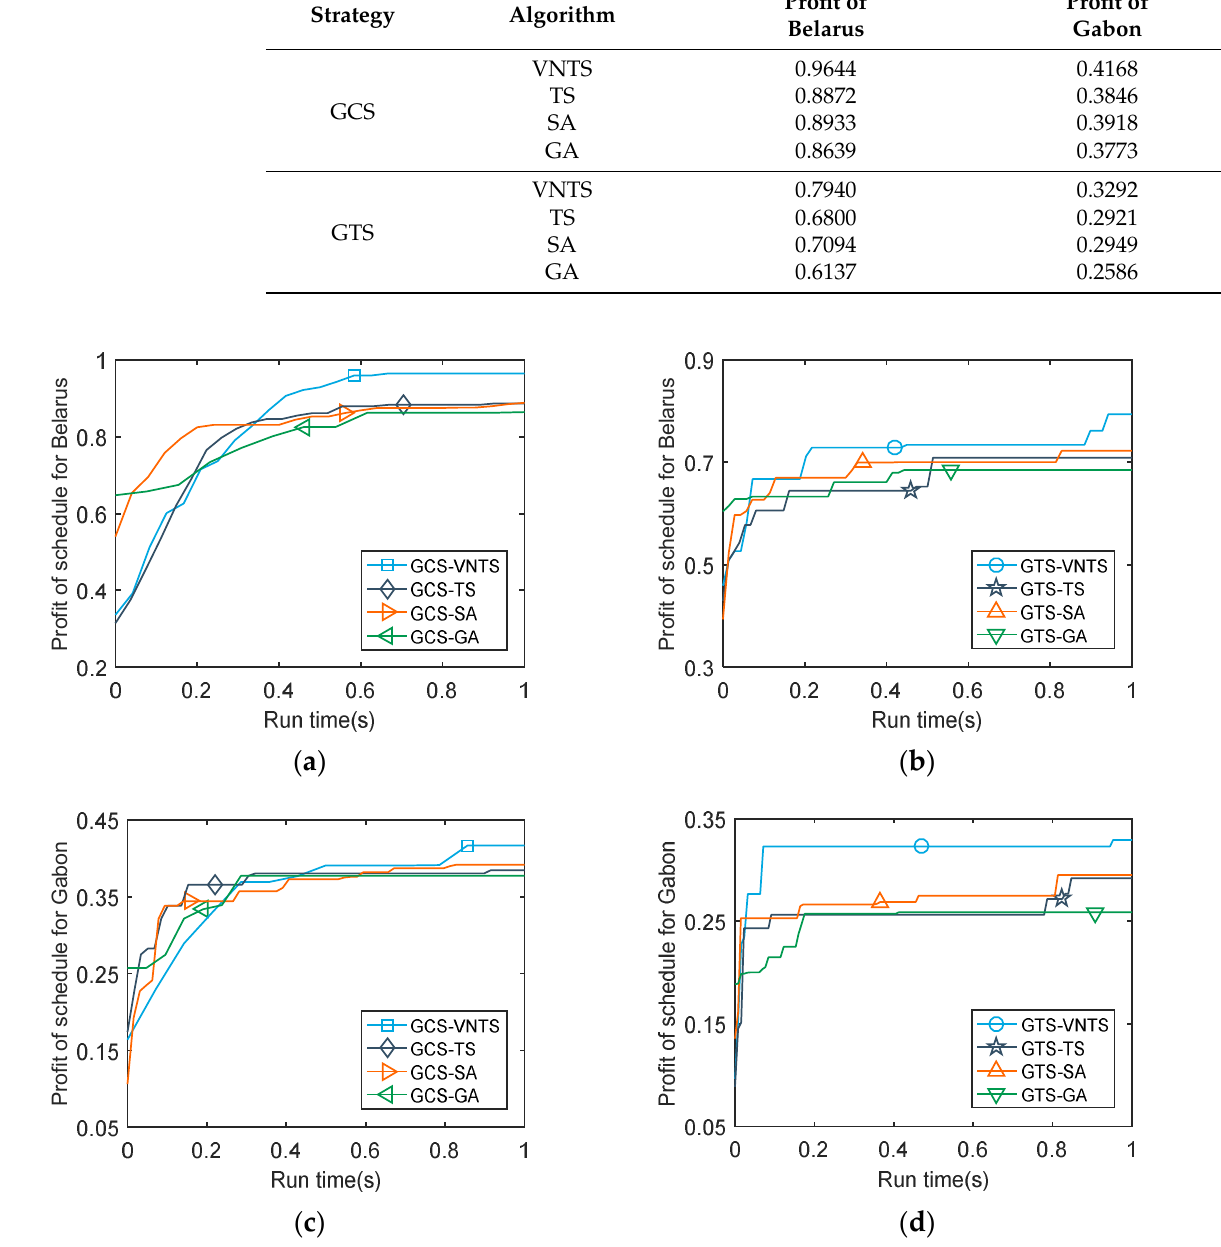
Figure 9. The profit of the obtained schedule versus the run time of CPU. ( a ) The profit of schedules for Belarus using the GCS strategy; ( b ) the profit of schedules for Belarus using the GTS strategy; ( c ) the profit of schedules for Gabon using the GCS strategy; ( d ) the profit of schedules for Gabon using the GTS strategy.